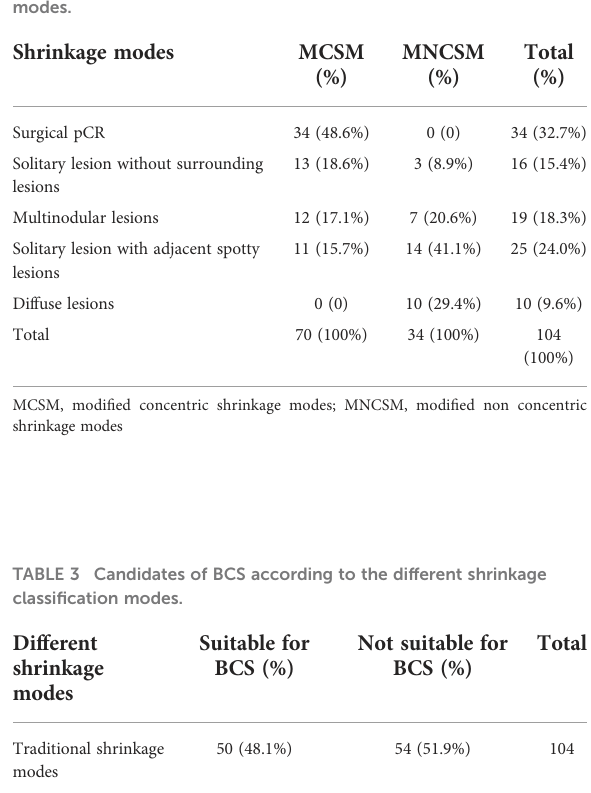
TABLE 1 The clinical characteristics of 104 patients.